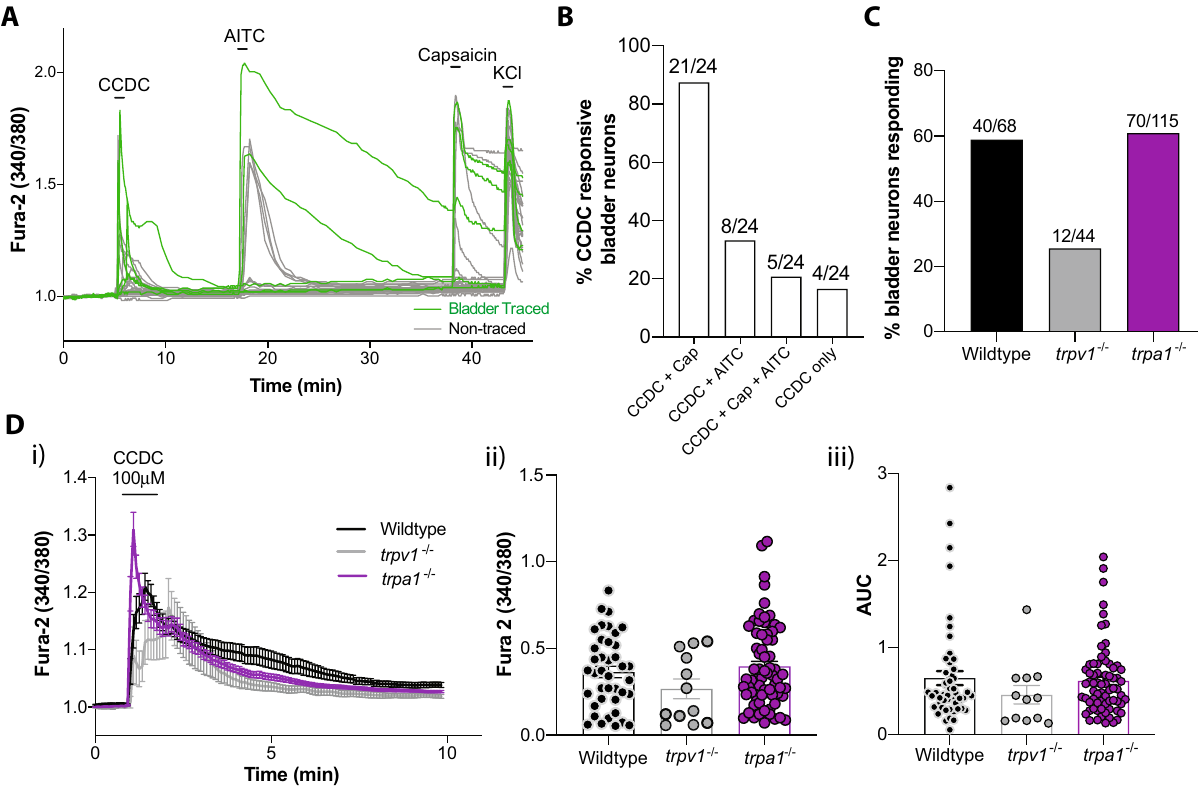
Figure 7. Intracellular calcium responses to CCDC in trpv1 −/− and trpa1 −/− mice. ( A ) Live cell calcium imaging was performed on isolated, bladder-traced DRG neurons from WT, trpv1 −/− and trpa1 −/− mice to determine changes in intracellular Ca 2+ in response to direct application of CCDC. An example experiment showing bladder traced (green) and non-traced (grey) neurons from a single coverslip, with each line representing a single neuron over time and an increase in the Fura-2 fluorescence ratio (340/380) indicating an increase in intracellular Ca 2+ , from baseline normalised to a ratio of 1. The TRPA1 agonist AITC (100 µM) and TRPV1 agonist capsaicin (50 nM) were applied in succession following CCDC (100 µM) and washout periods to determine co-activation of neurons. KCl was added at the end of each experiment as a positive neuronal control. ( B ) The percentage of neurons co-responding with CCDC to each compound. Of the CCDC-responsive neurons 87.5% (21/24) also responded to capsaicin, whilst 33.3% (8/24) of CCDC-responsive bladder-traced neurons also responded to AITC. Only 16.7% (4/24) of CCDC-responsive bladder-traced neurons were unresponsive to both AITC and capsaicin. ( C ) The percentage of bladder-traced neurons responding to CCDC in WT, trpv1 −/− and trpa1 −/− mice. Compared to 58.8% observed in wildtype neurons, only 27.3% of trpv1 −/− bladder-traced neurons (12 out of 44; N = 4) responded to CCDC, whilst 60.9% of bladder-traced neurons from trpa1 −/− mice responded to CCDC (70 out of 115; N = 5). ( D ) ( i ) An average response curve for each population was determined from the CCDC-responsive bladder-innervating DRG neurons, to visually compare the neuronal responses between wildtype (black), trpv1 −/− (grey), and trpa1 −/− (purple) bladder neurons. ( ii ) maximum peak fluorescence and ( iii ) area under the curve (AUC) of fluorescence were compared across neurons from wildtype (black), trpv1 −/− (grey), and trpa1 −/− (purple) mice. No significant differences between either trpv1 −/− or trpa1 −/− neurons and wild-type neurons were observed. Data are represented as percentage of neurons ( B , C ) or mean ± SEM ( Di , Dii , Diii ). P values were determined using Kruskal–Wallis non-parametric ANOVA tests with subsequent Dunn’s post hoc multiple comparisons DRG neuron responses to CCDC supports previous studies whereby CCDC activates sub-populations of colonic and cutaneous DRG neurons 24,26 . However, unlike these previous studies, significant functional co-expression was observed between TGR5 and TRPV1 (CCDC and capsaicin responsive) with less interaction observed between TGR5 and TRPA1 (CCDC and AITC responsive). These data correspond with our mRNA expression data which demonstrates extensive Gpbar1 and trpv1 co‑expression, suggesting an alternative downstream coupling mechanism for TGR5 to that seen in colonic or cutaneous DRG neurons. The potential associations of in vitro CCDC activity with TRPA1 and TRPV1 were further dissected using DRG from trpa1 −/− and trpv1 −/− mice. Data from these DRG neurons demonstrate that CCDC-induced activation of bladder-innervating DRG neurons was greatly reduced in trpv1 −/− DRG neurons, whilst no significant differences in CCDC responses were observed in the absence of trpa1 . Together, these data indicate that TGR5 signalling in bladder afferents is partially mediated by TRPV1 as a potential downstream effector.